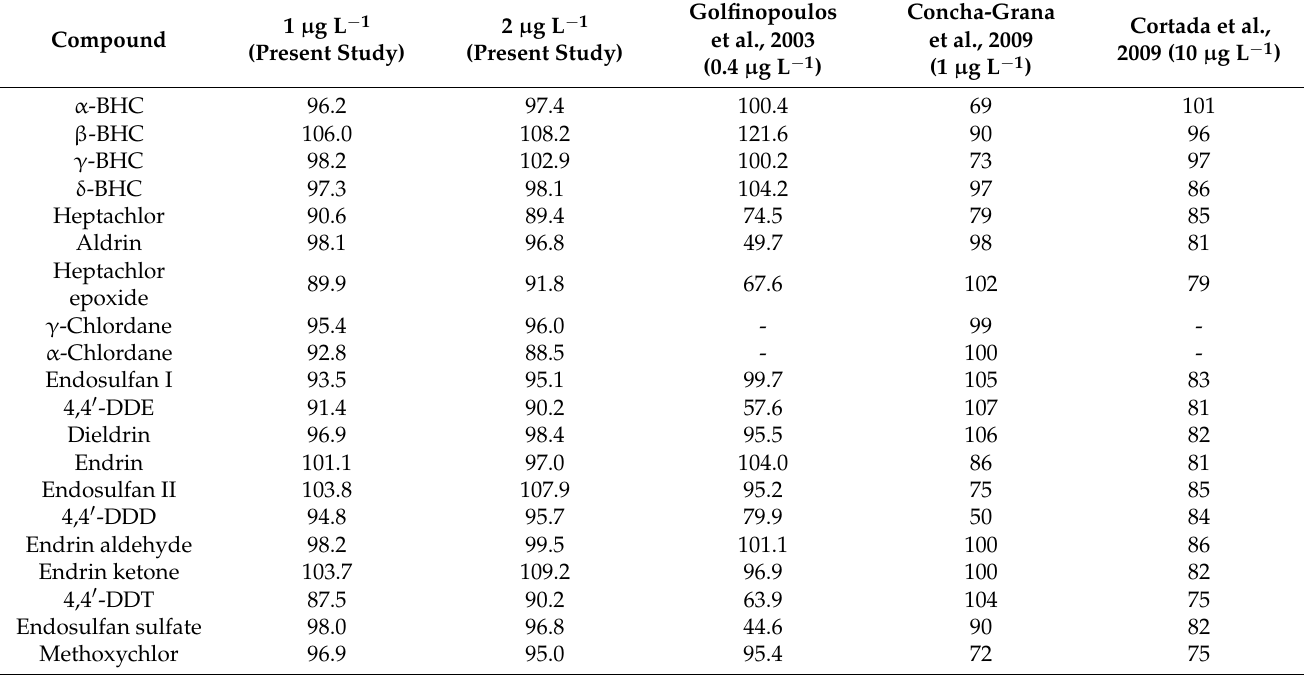
Table 3. Percent recovery values of selected pesticides at two concentration levels by using SPME-GC-ECD technique and comparison with some reported